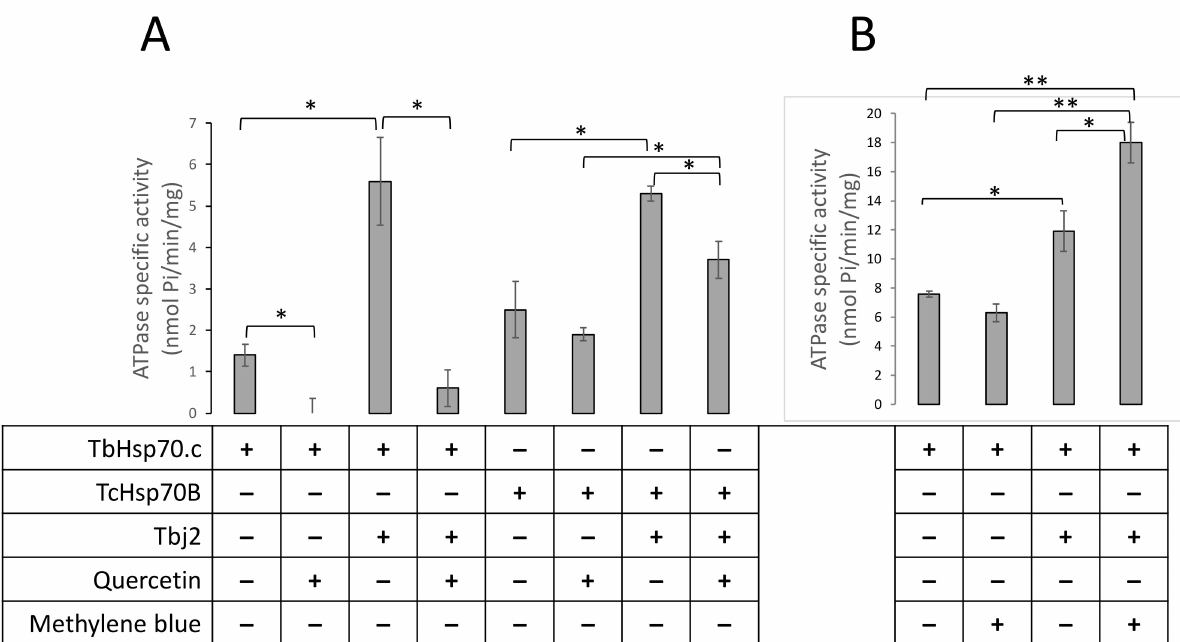
Figure 8. Quercetin inhibits whilst methylene blue enhances TbHsp70.c-Tbj2 activity. The effect of quercetin ( A ) and MB ( B ) on the basal and Tbj2-stimulated ATPase activity of TbHsp70.c and TcHsp70B was investigated. Inorganic phosphate released by ATP in the presence of each Hsp70 was monitored by direct calorimetry at 595 nm wavelength. TbHsp70.c, TcHsp70B, and Tbj2 concentrations were maintained at 0.4 µ M, and ATP was present in all reactions at 600 µ M ( A ). Quercetin was present in the reactions as indicated at 30 µ M. The effect of MB on the basal ATPase activity of TbHsp70.c and TbHsp70.c in partnership with Tbj2 was investigated ( B ). TbHsp70.c and Tbj2 concentrations were kept constant at 1 µ M and ATP was present in all reactions at 600 µ M. MB was present at a concentration of 30 µ M. The error bars indicate data generated from three assays conducted using independent TbHsp70.c, Tbj2, and TcHsp70B protein preparations. Statistical significance was determined by using one-way ANOVA and post-hoc test (* p < 0.01; ** p <